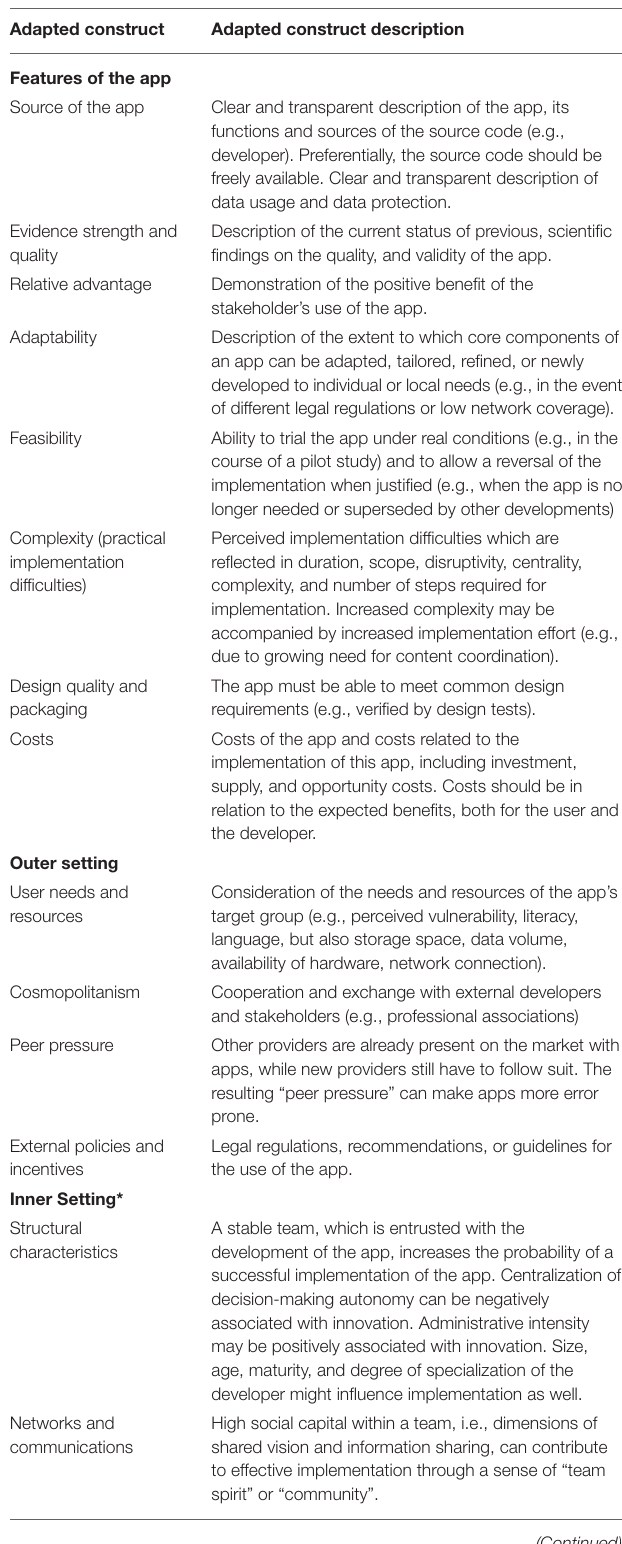
TABLE 1 | Overview of adapted CFIR constructs for the implementation of health